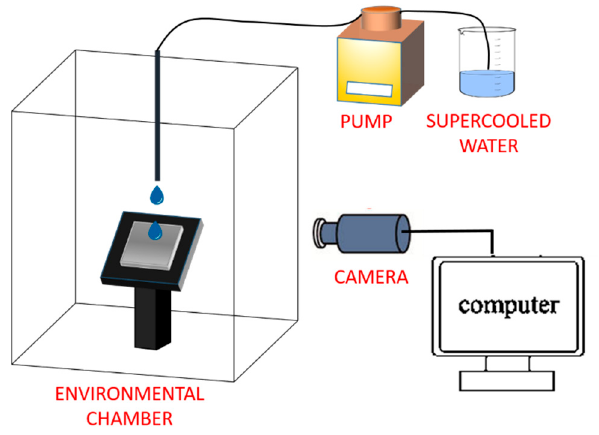
Figure 5. Schematic of a typical experimental setup for water dripping tests.